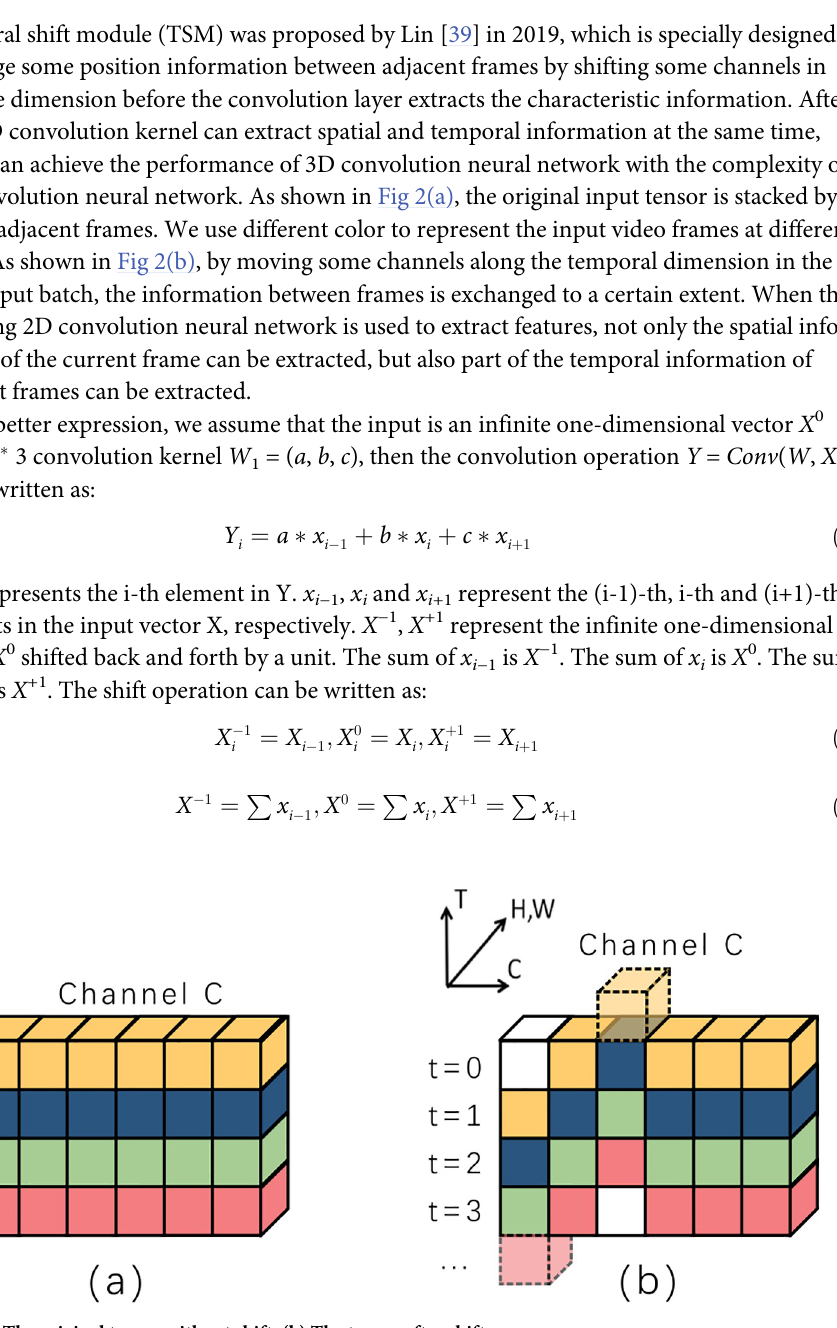
Fig 2. (a) The original tensor without shift, (b) The tensor after